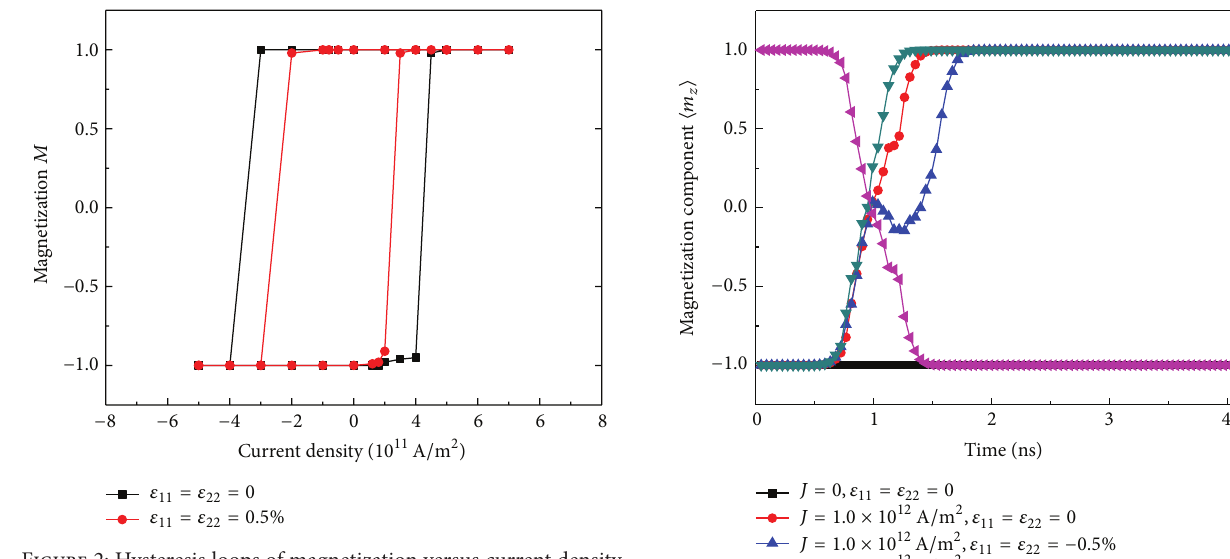
Figure 2: Hysteresis loops of magnetization versus current density with strain and without strain.